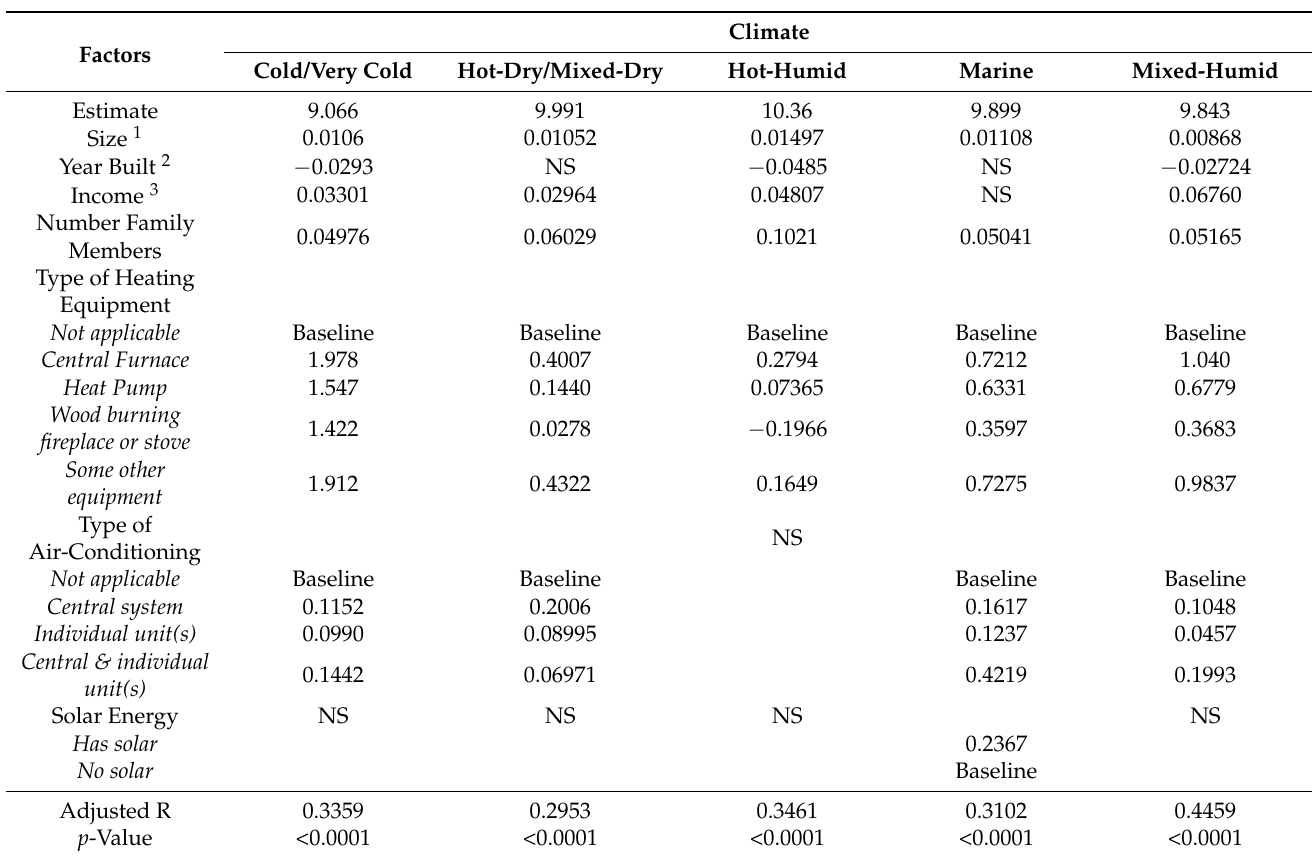
Table 3. Parameter estimates and summary results of regression per